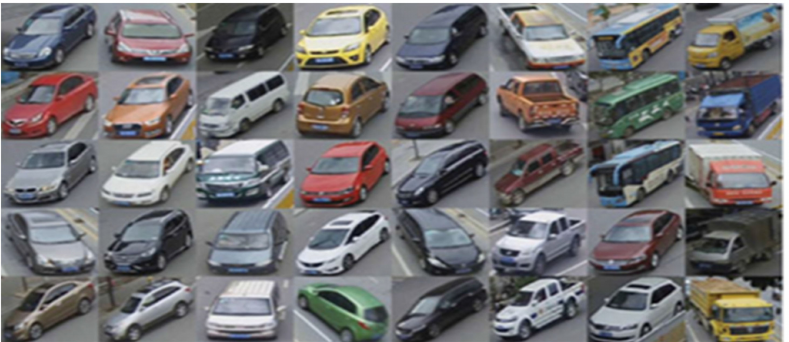
Figure 19. Depicts the sample images of VeRi-776